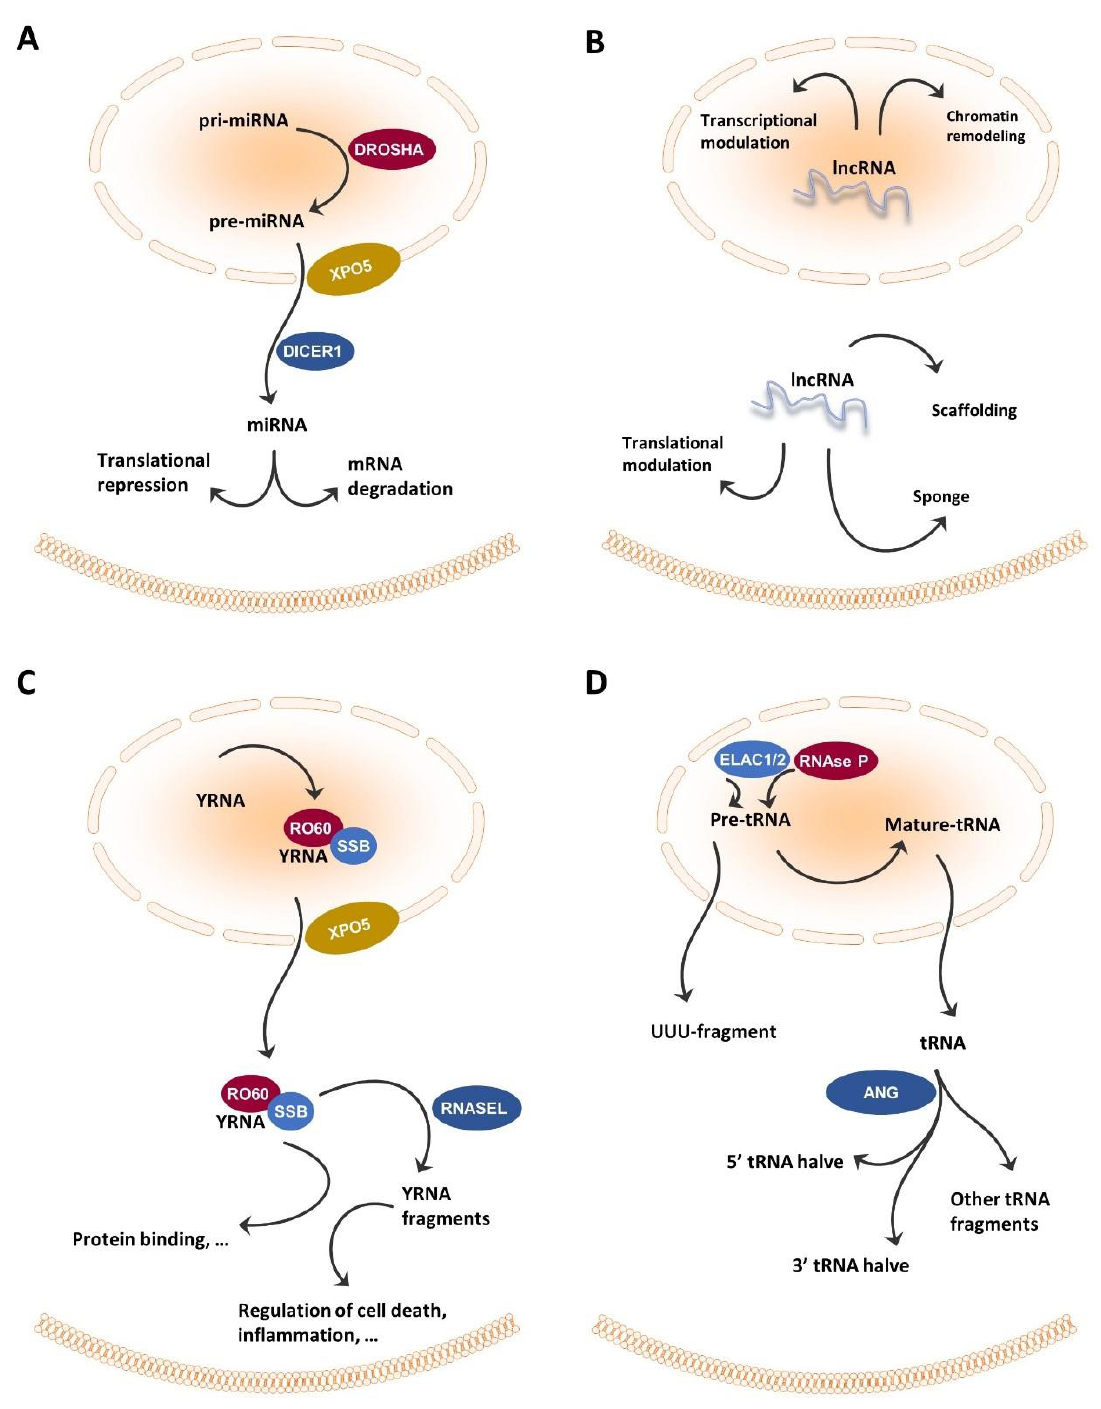
Figure 2. Biogenesis and functions of non-coding RNAs found in the circulating system in HNC patients. ( A ) Pri-miRNAs are converted into pre-miRNA by DROSHA, exported from the nucleus to the cytoplasm by XPO5, cleaved by DICER1, and assembled into the RISC complex, which allows translational repression or mRNA degradation. ( B ) lncRNAs engage in many cellular functions including miRNA sponging, protein scavenging, acting as a scaffold for proteins functioning together, chromatin remodeling support, and contributing active (or silencing) gene transcription and modulating mRNA functions. ( C ) ScnRNA, called YRNA, is transcribed (chromosomal location 7q36) and bound by SSB and RO60 proteins. In the cytoplasm YRNA is broken into fragments. ( D ) tRNAs are transcribed in the nucleus via RNA polymerase III as large precursors with 5′ - leader and 3 ′ -trailer sequences. The 5 ′ - leader sequence is cleaved out by RNase P and the 3′-trailer sequence is removed by ELAC1/2 (a.k.a. RNase Z) to yield mature tRNAs. tRNA halves are generated by anticodon-cleaving enzyme ANG.